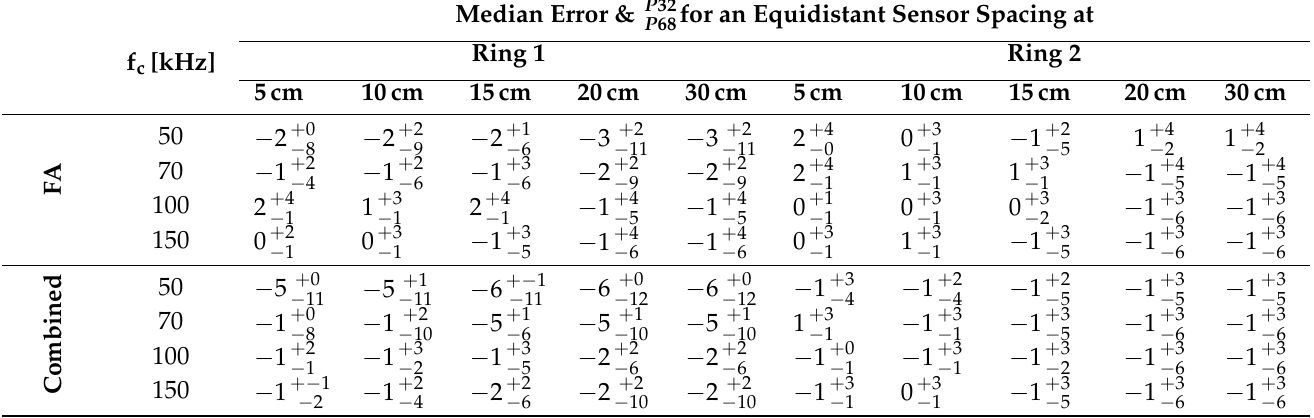
Table A1. Accuracy of the measured fluid top-level without distinguishing between water or